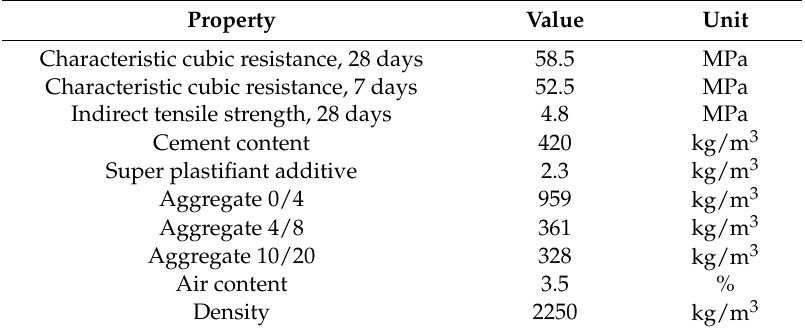
Table 8. Physic and mechanical properties of the designed concrete